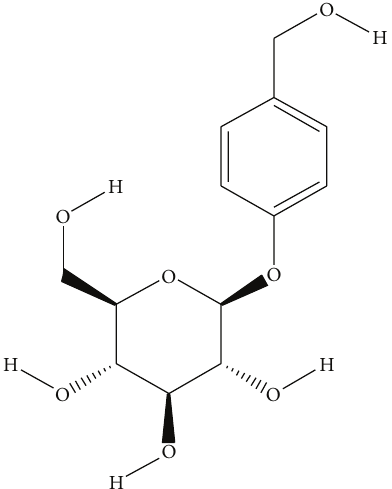
Figure 1: Structures of 4-hydroxybenzyl alcohol 4-O-beta-D-gluco- pyranoside